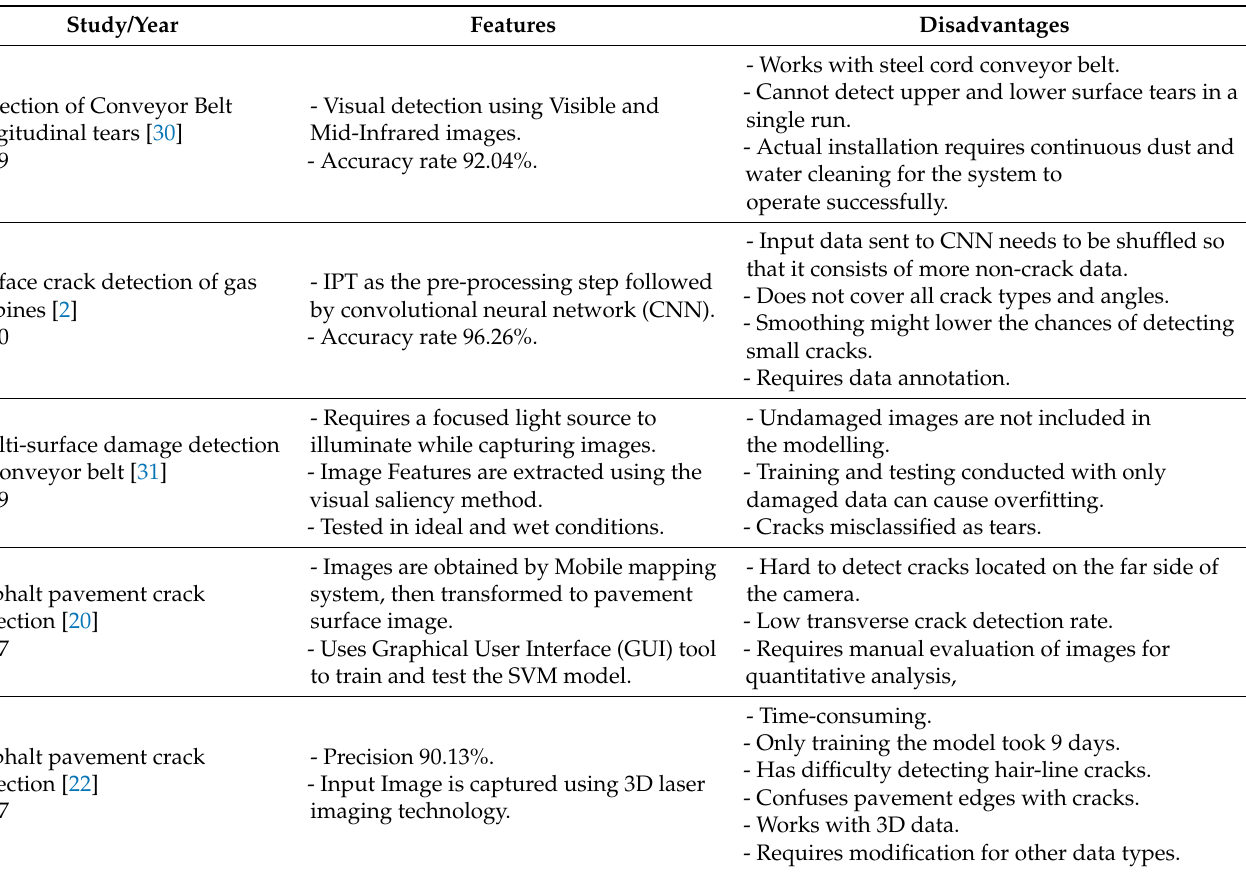
Figure 1. Envisioned IoT centric Machine Learning based UHF RFID SHM system. Table 1. Summary of Existing SHM Systems Based on ML-Based Techniques.